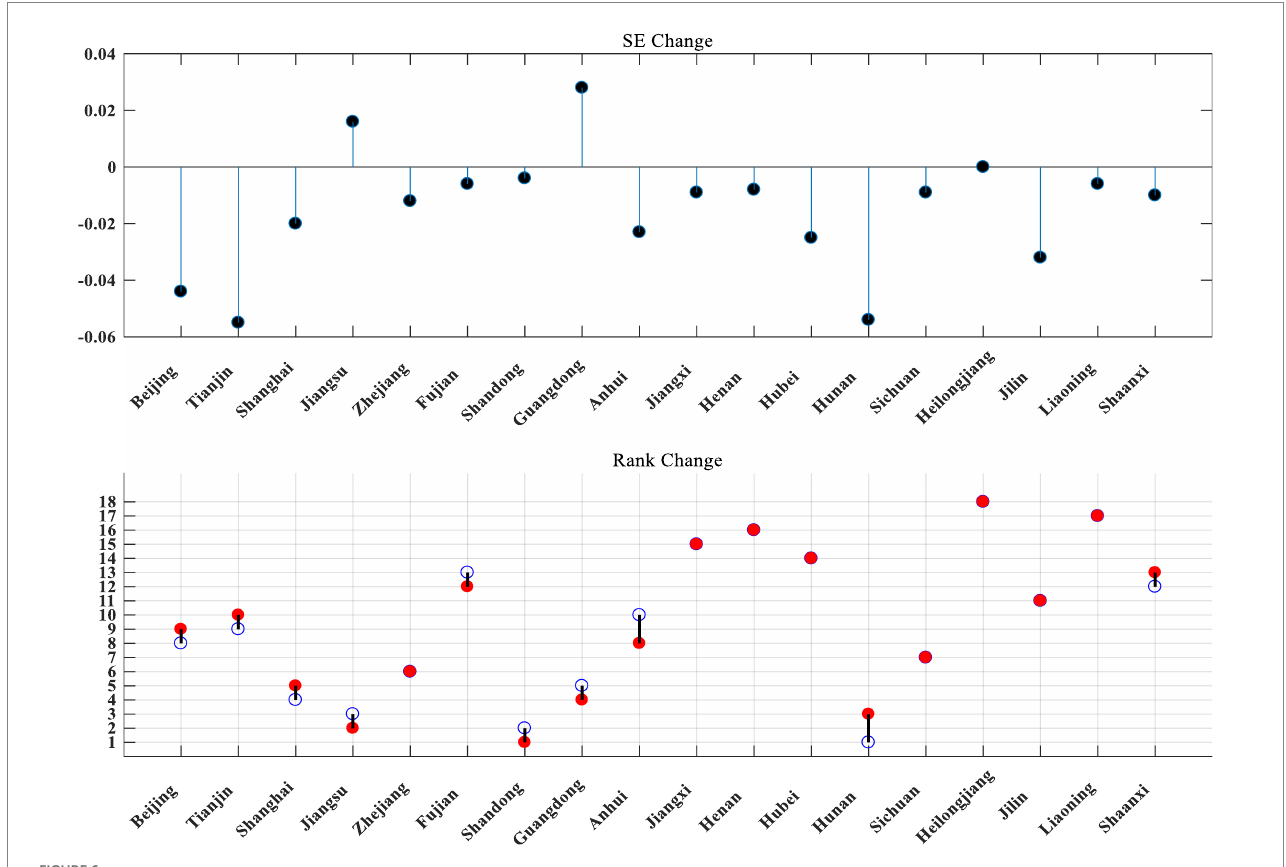
FIGURE 6 Three stages of SE change in technology and finance in strategic emerging